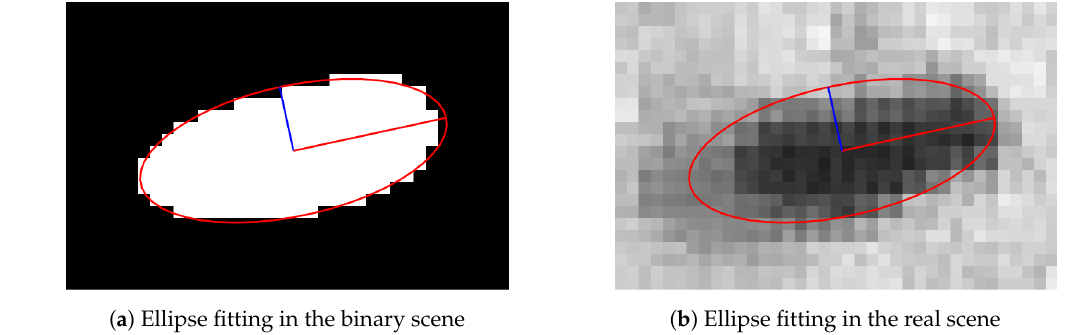
Figure 6. ( a ) Ellipse fitting result in the binary scene and ( b ) in the real scene. The ellipse fits the filtered data in the binary scene. The major and the minor axes are illustrated as the red and the blue lines, respectively. According to the real scene, the head of the fly and wings’ position both lie on the main axis. Being able to determine the position of the wings implies the position of the